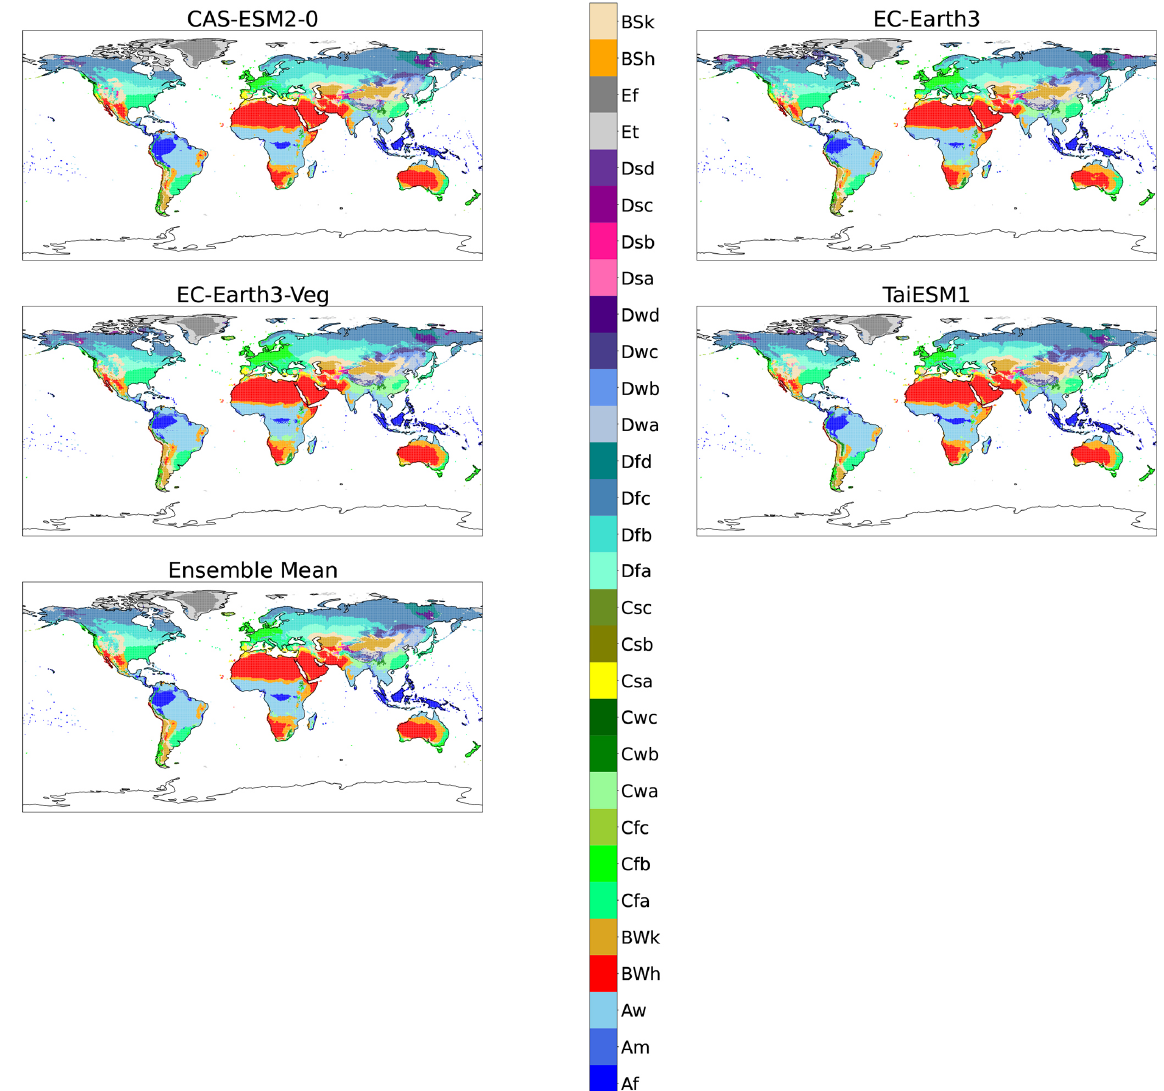
Figure A4. Maps of KG classifications for each model at + 2K with anomaly